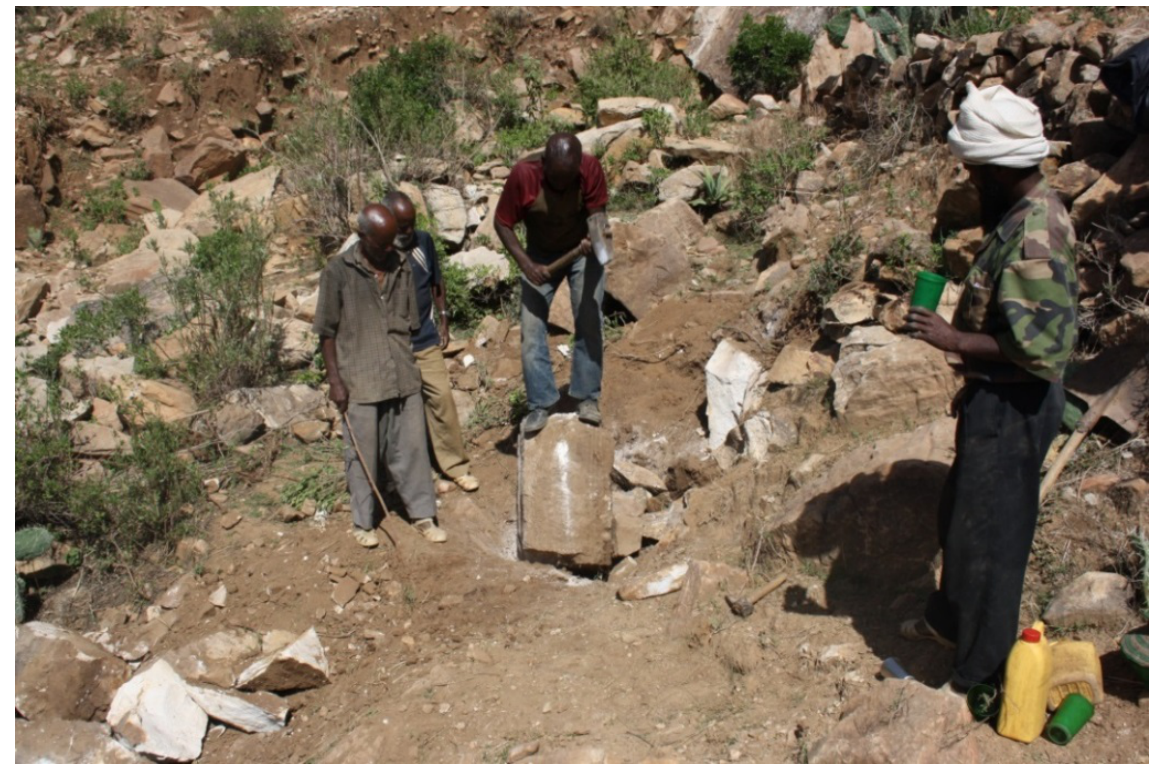
Figure 7. One man hammering in attempts to break the stone in